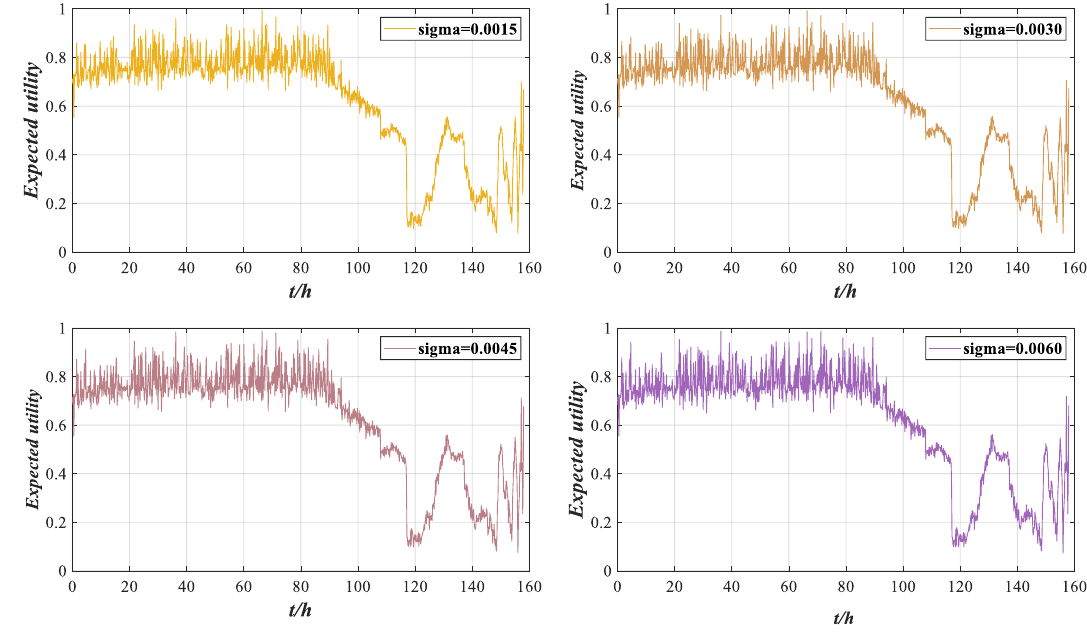
Figure 23. Expected utility of rolling bearing performance under different perturbation intensities.